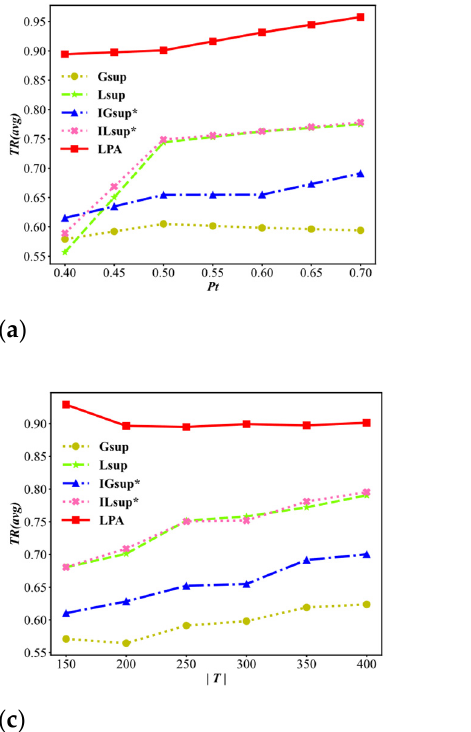
Figure 7. Average trajectory remaining ratio TR (avg) (higher is better). ( a ) Varying P t . ( b ) Varying | t | (avg). ( c ) Varying | T |